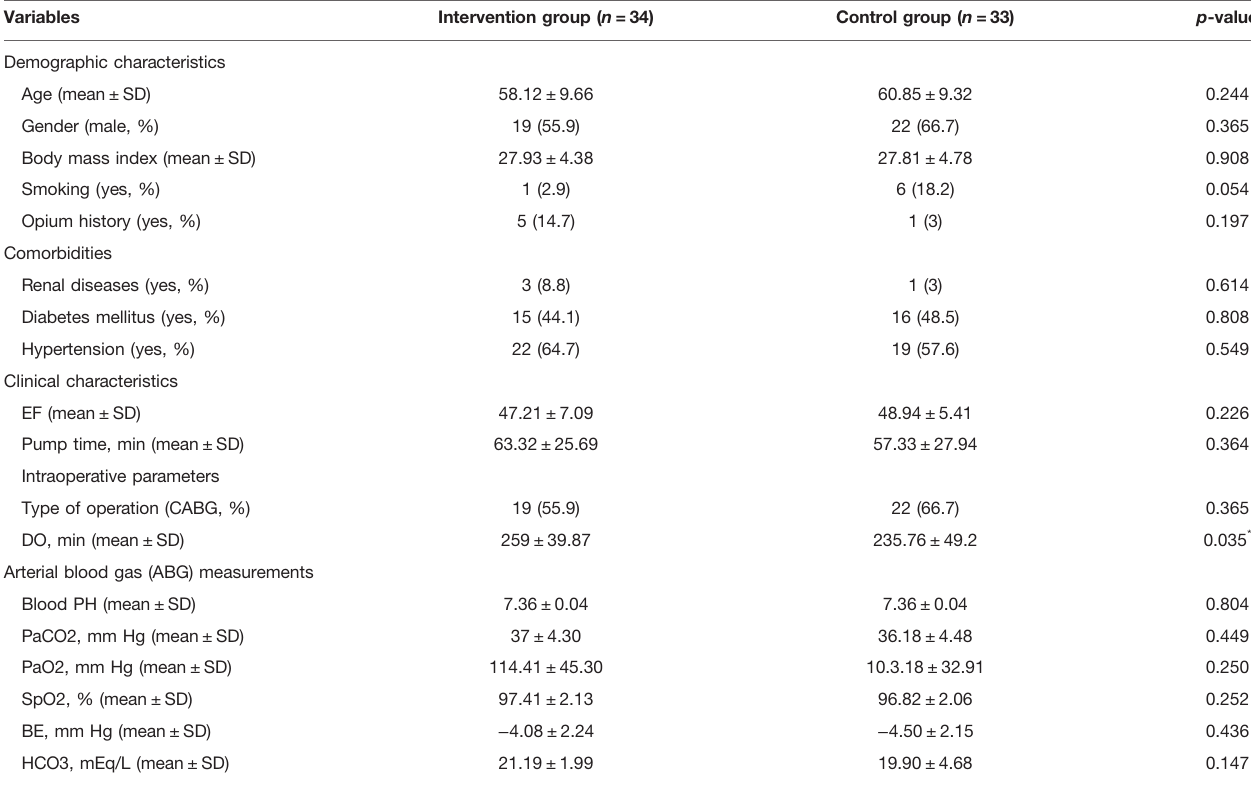
TABLE 1 | Baseline demographic and clinical characteristics of the participants in two groups of study.